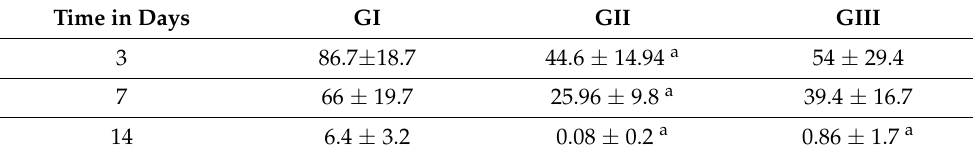
Table 5. Mean ± SD of WCP in full-thickness skin wounds in control and treated groups. Time in Days GI GII GIII 3 13.3 ± 18.7 55.4 ± 14.94